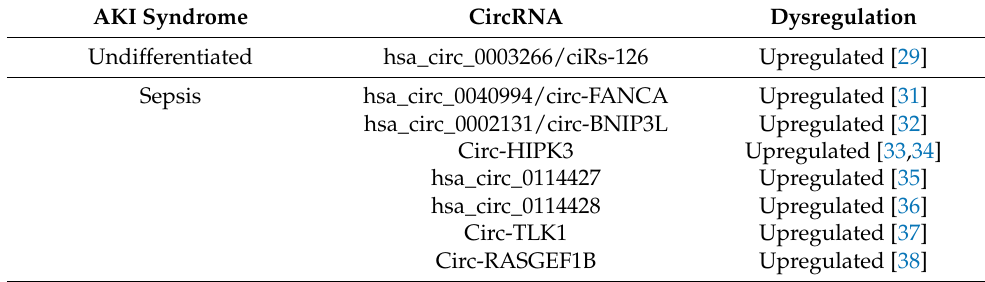
Table 1. Differentially expressed circRNAs in different syndromes of acute kidney injury